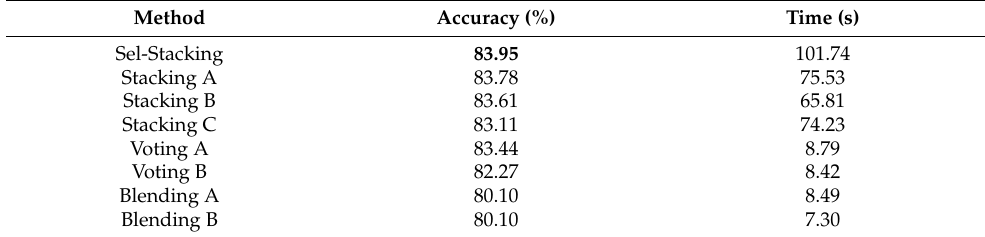
Table 16. The accuracy and running time of different model fusion methods.